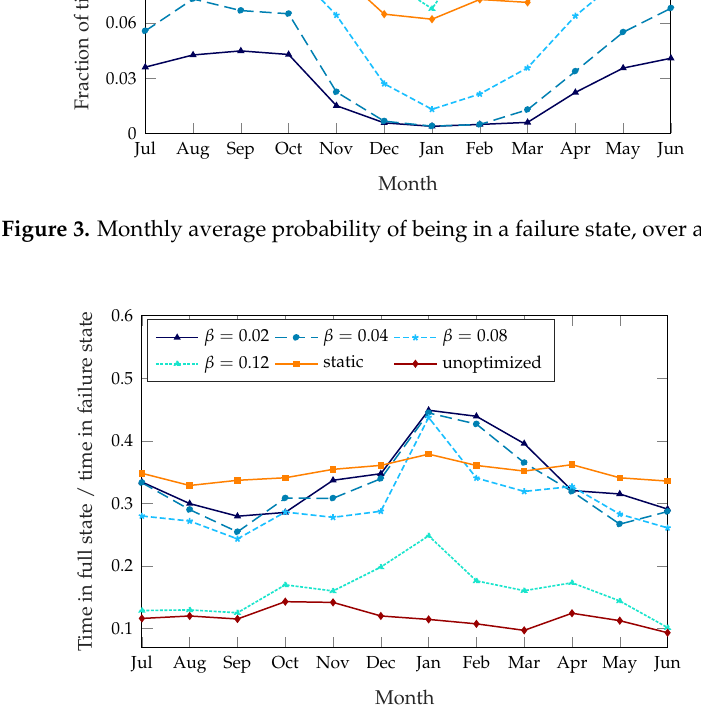
Figure 4. Fraction of failures due to full stations, over a